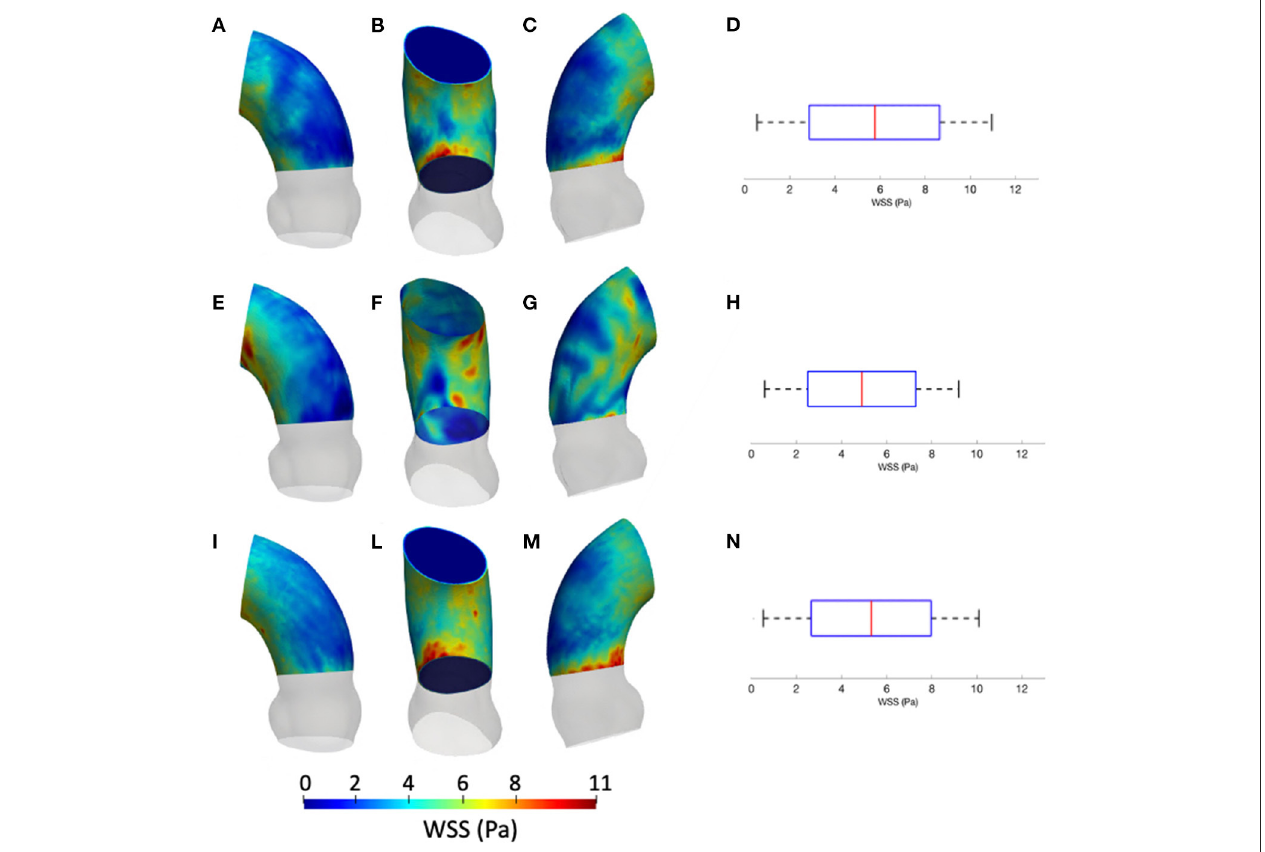
FIGURE 5 | Contour map of the wall shear stress (WSS) at systolic peak for geometry at phase p 0 considering the three different levels of smoothing: S L [min: 0.5 Pa, avg: 5.9 Pa, max: 11 Pa] (A–C) , S M [min: 0.4 Pa, avg: 4.9 Pa, max: 9.5 Pa] (E–G) and S H [min: 0.4 Pa, avg: 5.1 Pa, max: 10 Pa] (I–M) . The corresponding box plots are reported in D,H , and N ,